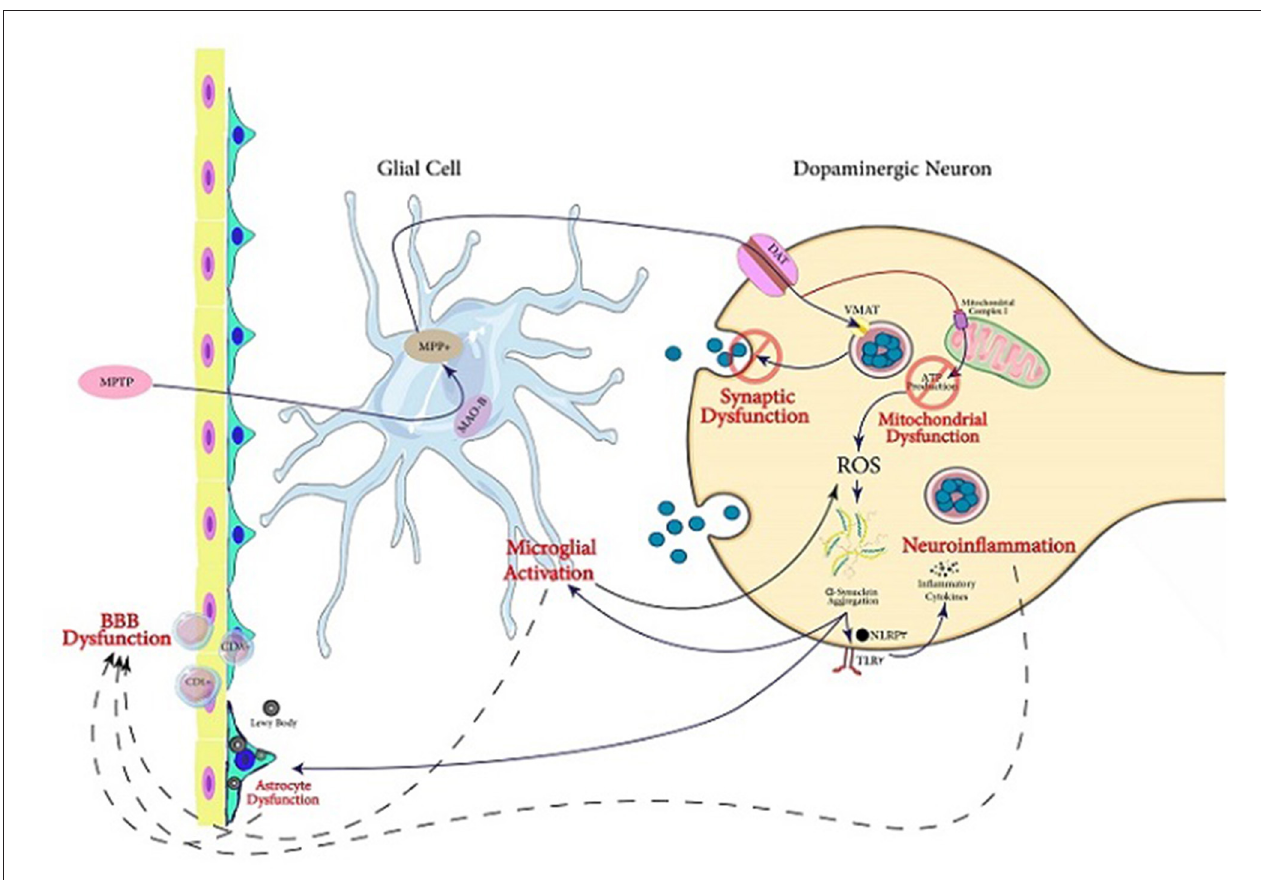
FIGURE 2 | Servier (2022) mechanisms involved in PD pathogenesis. In this figure, the mechanisms following MPTP exposure through which dopaminergic cell death occurs are illustrated. The active metabolite of MPTP, MPP + , is produced in glial cells and transfers into dopaminergic neurons via DA transporter. In the neuron, this activated metabolite causes synaptic dysfunction as well as mitochondrial dysfunction which triggers aggregation of α -Syn. It also can lead to neuroinflammation and microglial activation. Acting together, the mentioned mechanisms can lead to dysfunction of BBB, which is one of the main pathological findings in PD, in addition to Lewy bodies and α -Syn